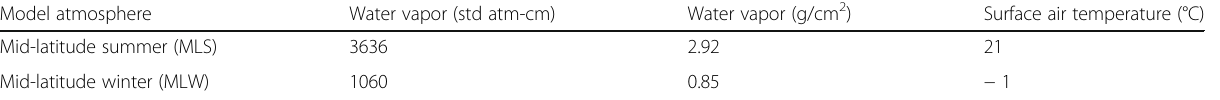
Table 1 Column water vapor amounts and surface temperatures for the MODTRAN model atmosphere Model atmosphere